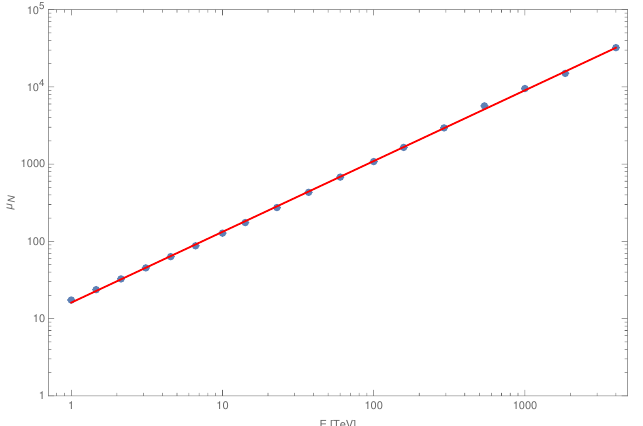
Figure A2. Values of Gaussian distribution parameter µ (for muons) for different energies of the vertical cascades and protons as the primary cosmic-ray